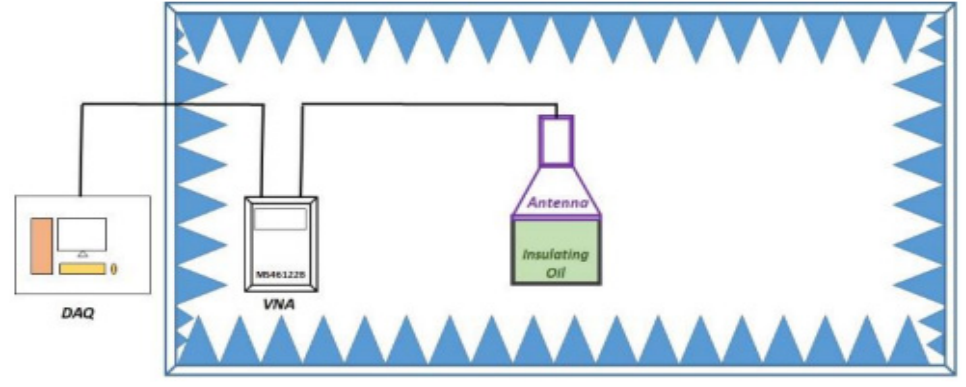
Figure 12. Antenna design setup [9].